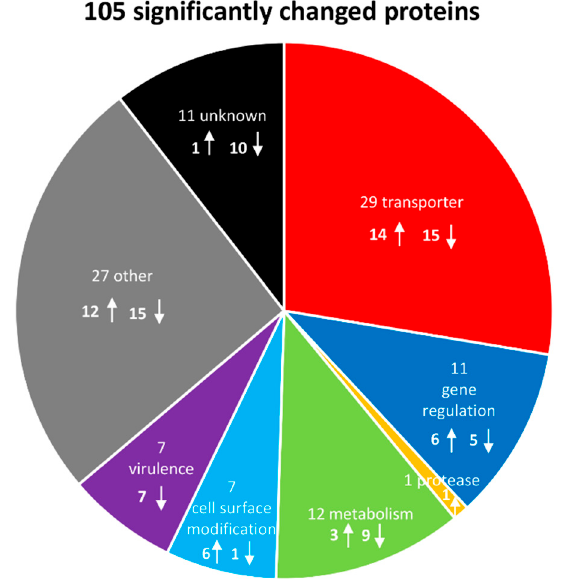
Figure 5. Graphical representation of significantly# affected proteins and their function after LL-37 treatment. The arrows indicate an increase or a decrease in protein abundance after application of the stress, respectively. # Student’s t -test ( p -value = 0.01, min. fold change = 1.5).